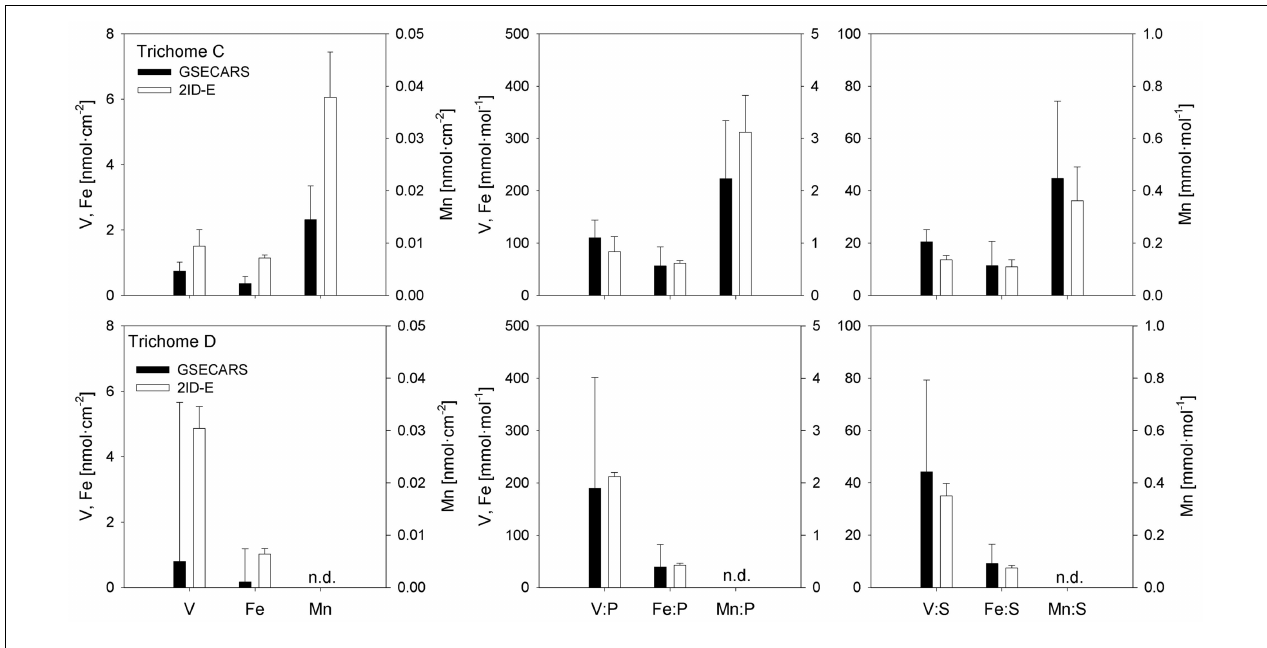
FIGURE 5 | Comparison of element concentrations in overlapping trichome sections analyzed with GSECARS and 2ID-E beamlines. The panels on the left presentV, Fe, and Mn concentrations as nmolcm − 2 .The